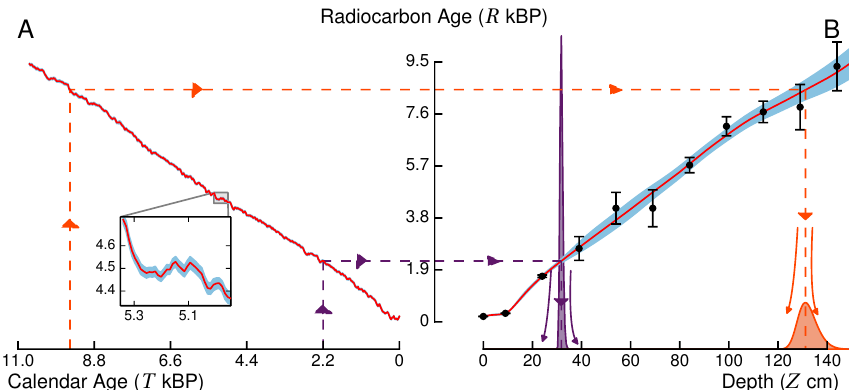
Figure 2. Depth-spanning weight functions (DWFs). (a) Radiocarbon calibration curve representing the mean (red) and ± 2 standard deviations (blue) of the distribution P(r | t) . Inset: calibration curve around 5.1kBP detailing non-monotonicities. (b) (i) 14 C measurements from a simulated archive (circles with error bars representing the distribution P(r | z r | k ) ) and the RM age model obtained from them: mean (red) and ± 2 standard deviations (blue) of the distribution P(r | z x | j ) that results from the used regression method. (ii) DWFs for the calendar ages 2.2kBP (purple) and 9.5kBP (orange). The corresponding colored dashed lines with arrows indicate how a given calendar age is related to a distribution over probable depths via the DWF. All uncertainty bounds correspond to ≈ 95% confidence. (Color online.)